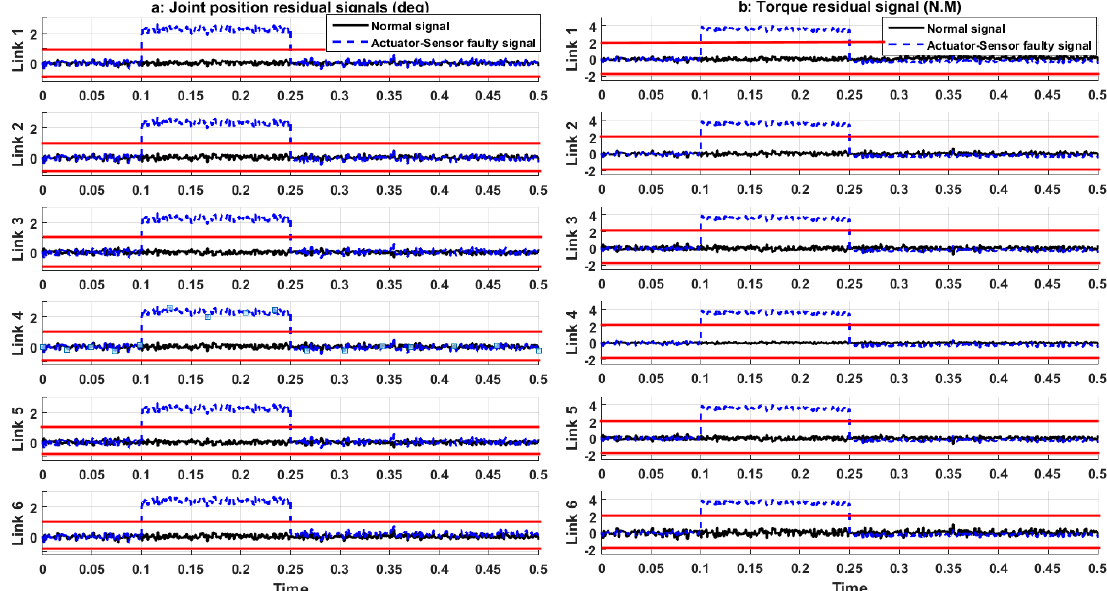
Figure 14. Residual signals in the actuator–sensor faulty condition: ( a ) Joint variable residual signals and ( b ) torque residual signals.